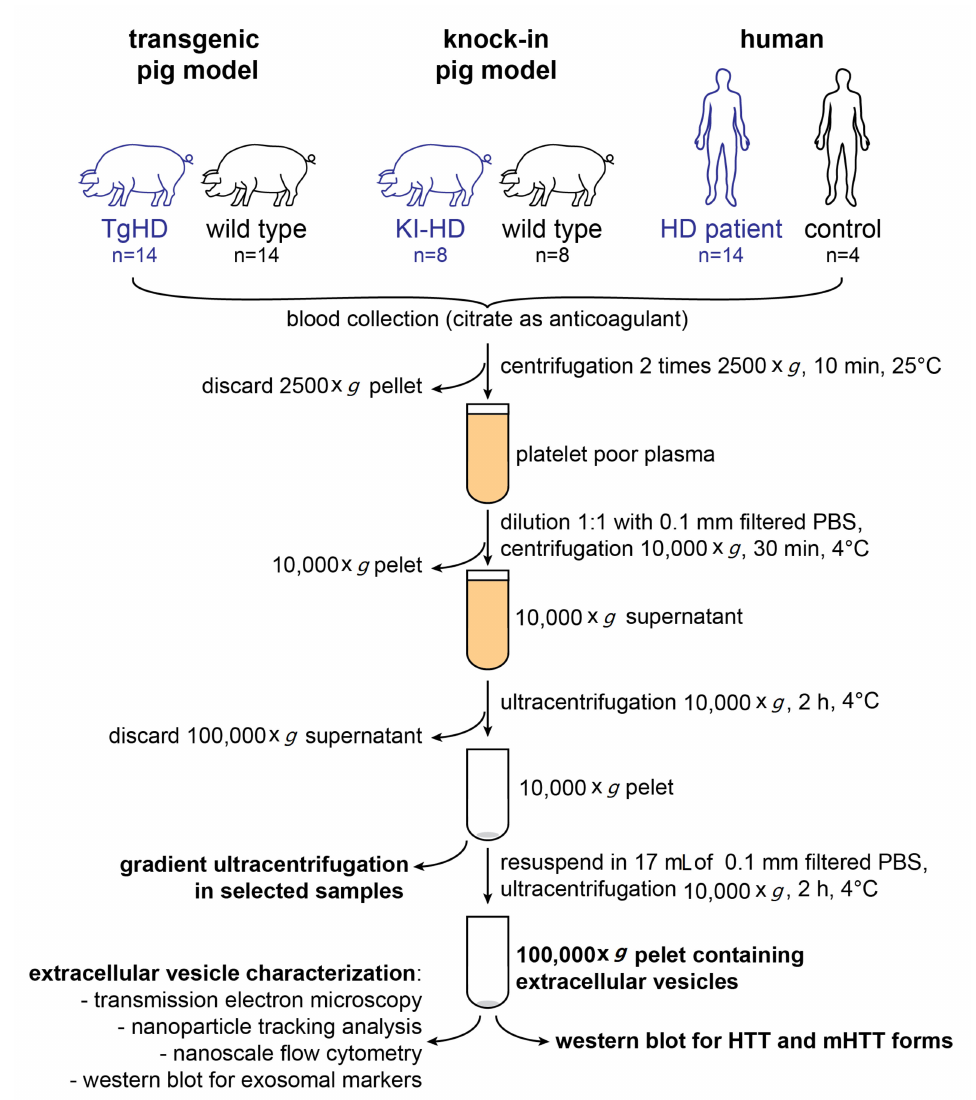
Figure 1. Experimental